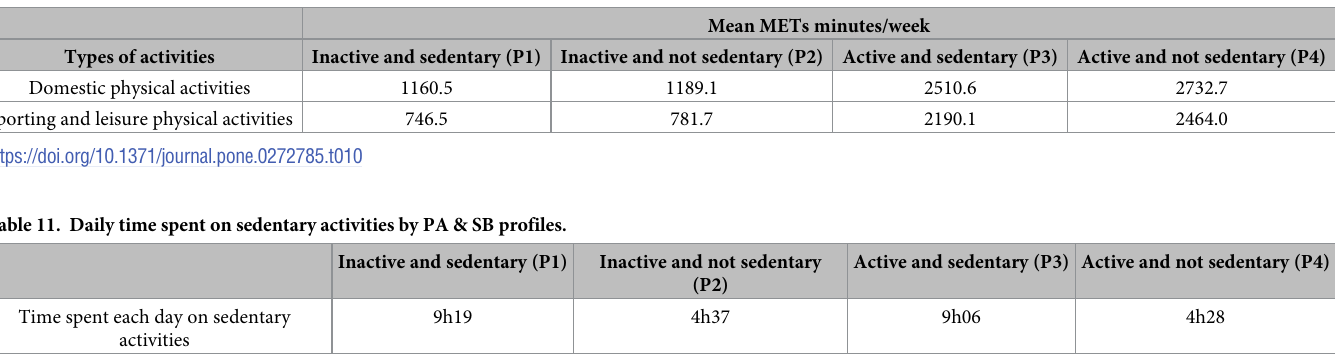
Table 10. Energy expenditure linked to PA by PA & SB profiles.